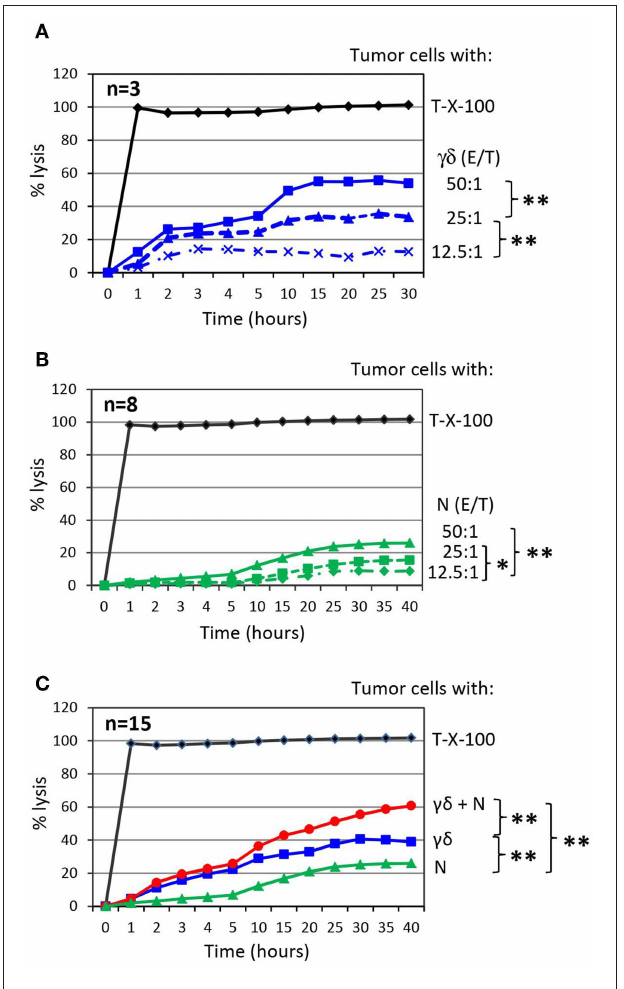
FIGURE 2 | Co-culture of γδ T cells with autologous neutrophils in the presence of PDAC enhances cytotoxicity. (A) Cytotoxicity induced by short-term activated γδ T cells ( γδ ) at the indicated Effector/Target ratio (E/T). The mean of three individual samples for the indicated time points are shown. (B) Cytotoxicity induced by neutrophils (N) at the indicated Effector/Target ratio (E/T). E/T ratio was 12.5:1 (dashed line with x, 62.500 effector cells), 25:1 (dashed line with triangle, 125,000 effector cells) and 50:1 (solid line with square, 250,000 effector cells). The mean of eight individual samples for the indicated time points are presented. (C) Cytotoxicity of 250 x 10 3 neutrophils (N, green line) or 125 × 10 3 γδ T cells ( γδ , blue line, E/T 25:1) alone or in combination ( γδ + N, red line) against Panc89 cells was measured by RTCA. The mean of 15 individual samples for the indicated time points are shown. Percentage of lysis was analyzed from RTCA data by calculating the normalized impedance of spontaneous lysis (cell growth of tumor cells in medium alone) in relation to the maximal lysis induced by 1% Triton-X-100 (T-X-100, black line) at indicated time points. (A–C) Statistical analysis was performed by t -test. Significances are presented as P -Value; ** P < 0.01 and * P < 0.05.